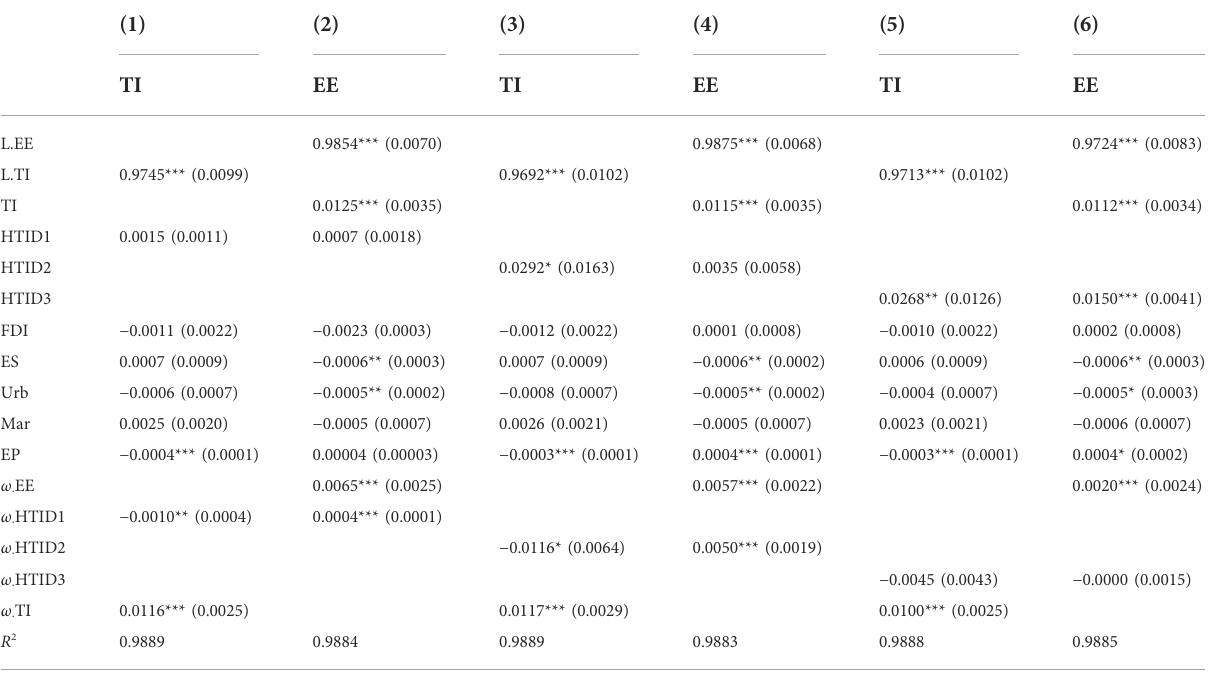
TABLE 4 Intermediary effect test of technological innovation.